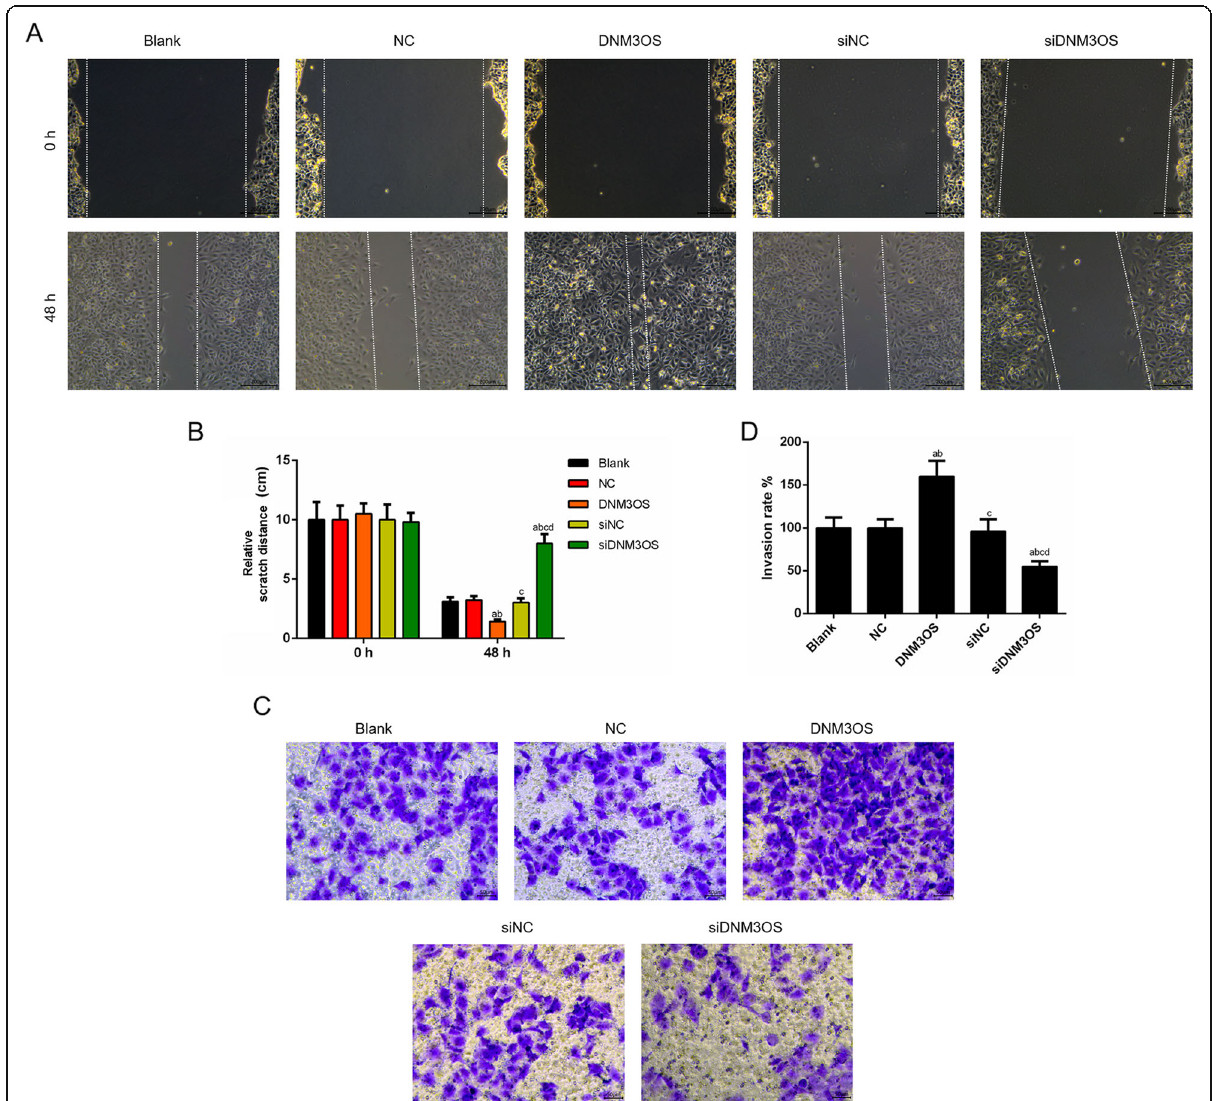
Fig. 3 CHON-001 cell migration and invasion were facilitated by the up-regulation DNM3OS, while the knockdown of DNM3OS showed opposite results. ( a ) CHON-001 cells migration was promoted by DNM3OS, while silencing DNM3OS inhibited cells migration as indicated by wound healing assay. ( b ) The distance of scratch was quantified. ( c ) CHON-001 cells invasion was enhanced by DNM3OS, while silencing DNM3OS suppressed cells invasion as indicated by transwell assay. ( d ) The number of invasion cells was quantified. a P < 0.05 vs. Blank, b P < 0.05 vs. NC, c P < 0.05 vs. DNM3OS, d P < 0.05 vs. siNC. siDNM3OS: small interfering dynamin 3 opposite strand; NC: negative